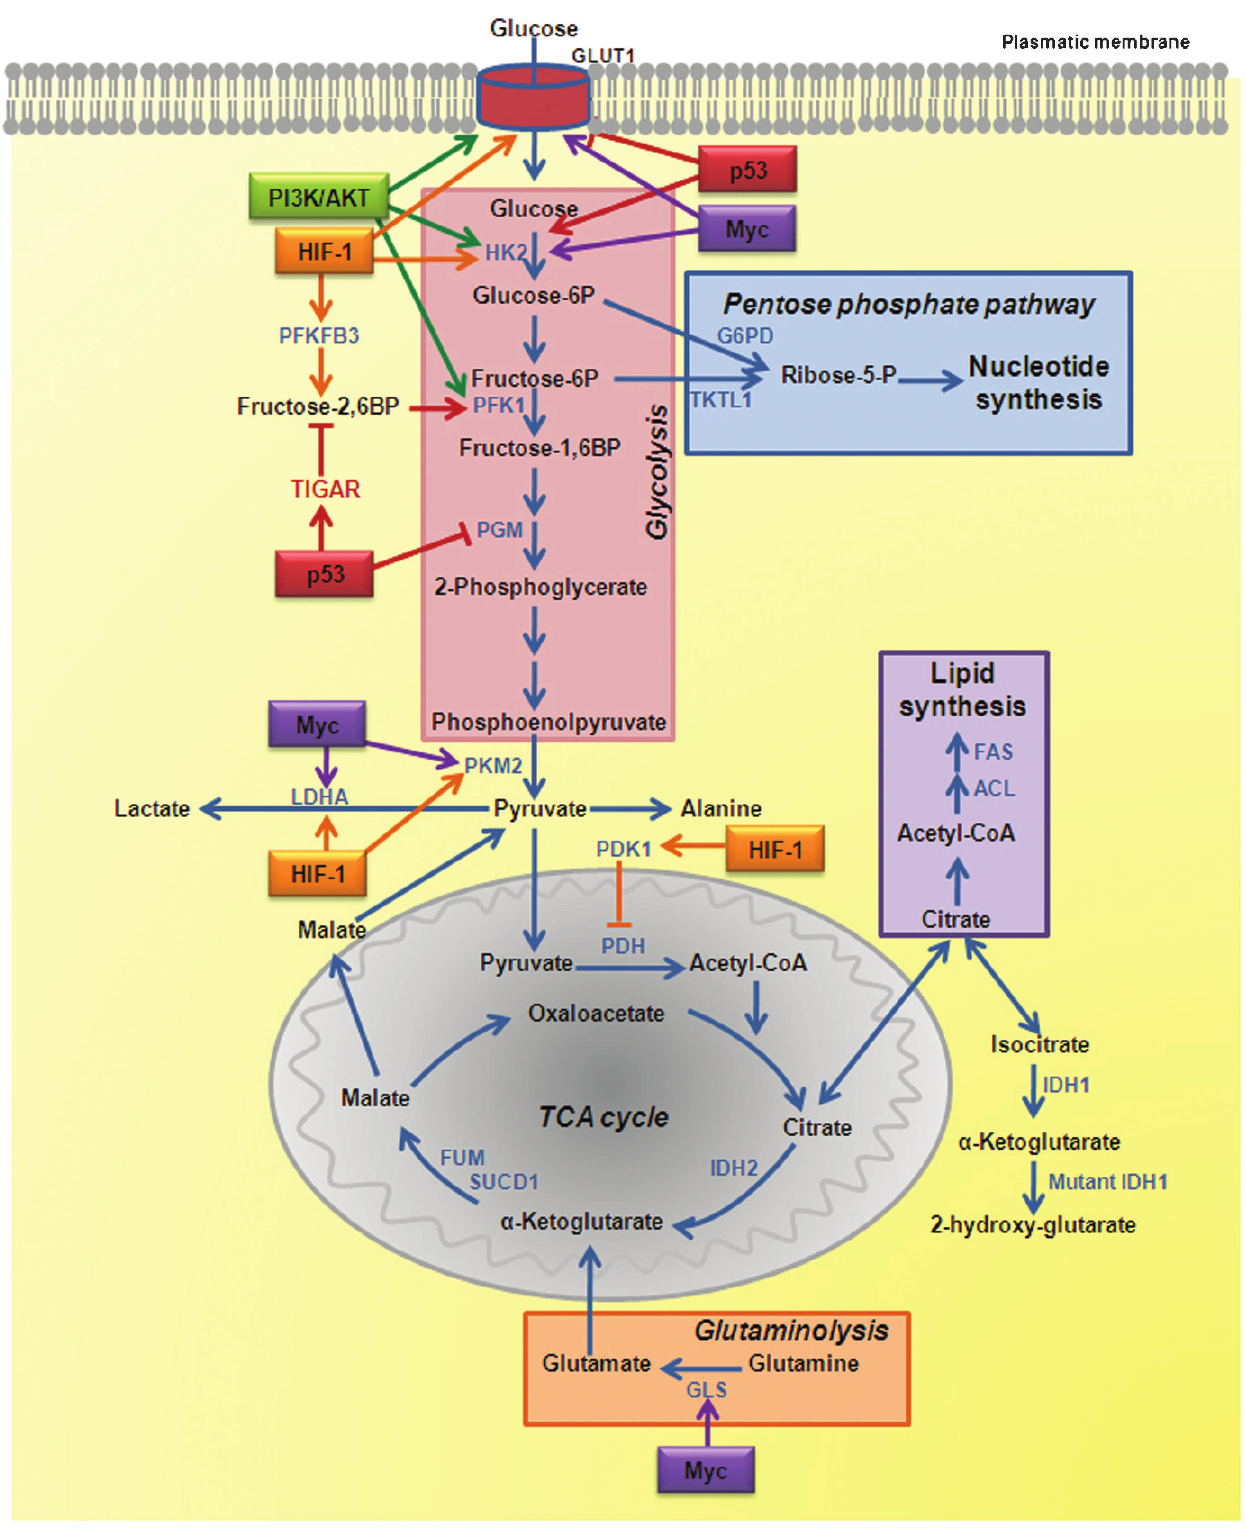
Figure 2 - Metabolic remodeling in cancer cells and regulation by signaling pathways involving oncogenes and tumor suppressor genes. The key enzymes of glycolysis, the TCA cycle, the pentose phosphate pathway, glutaminolysis, nucleotide, and lipid biosynthesis are shown as the regulation points by oncogenes and tumor suppressor